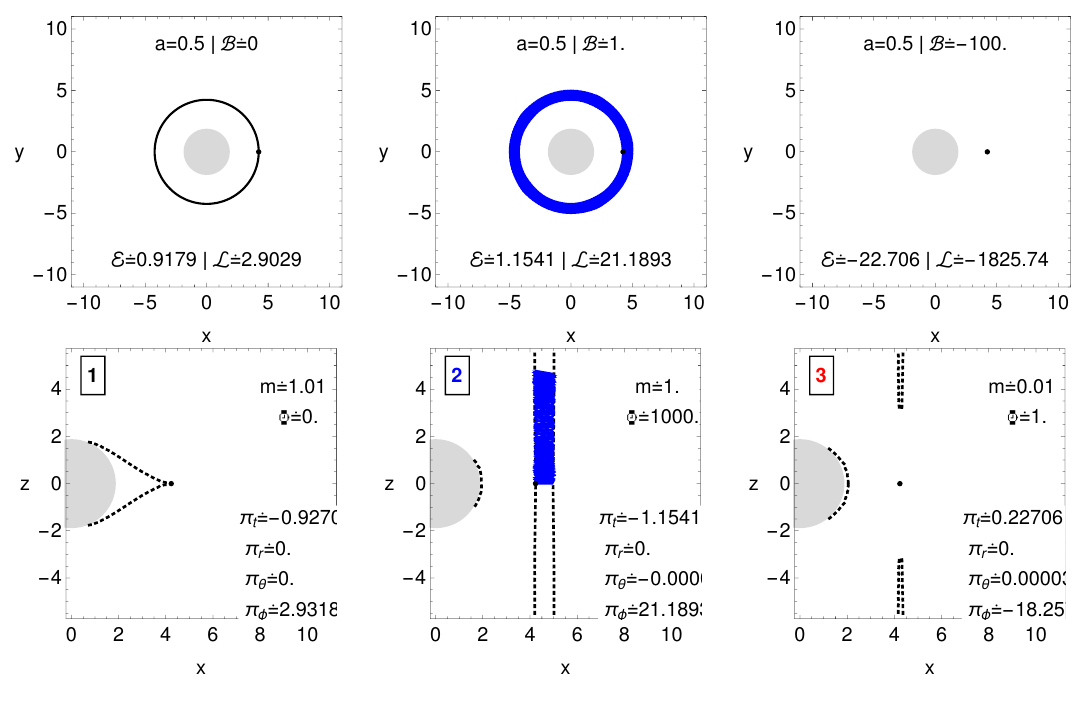
parameter is too B